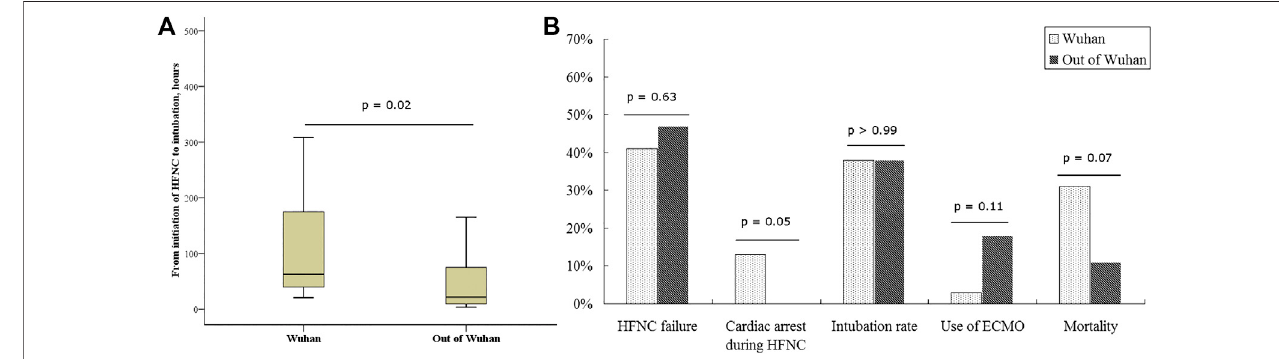
FIGURE3| ThecomparisonsbetweenpatientsinandoutofWuhan.HFNC,high- fl ownasalcannula;ECMO,extracorporealmembranousoxygenation.InWuhan, averylargenumberofpatientscrowded intohospitals,staffwereoverwhelmed,andasevereshortageofmedicaldevicesoccurred;thus,Wuhanistobeconsideredas a resource-limited